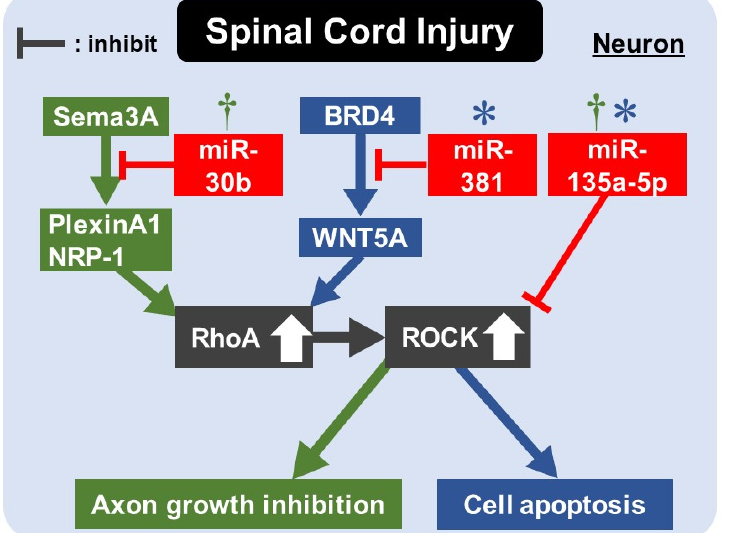
Figure 3. Schematic representation of the interaction between the Rho/ROCK pathway and miRNAs in spinal cord injuries. Spinal cord injuries trigger multiple signaling pathways that upregulate the Rho/ROCK pathways in neurons, leading to neuron cell apoptosis and axon growth inhibition. MiR- NAs inhibit these signaling pathways, resulting in reduced cell apoptosis and the promotion of axon regeneration. † miRNA involving oxidative stress. * miRNA involving cell apoptosis. Sema3A: Sem- family member 5A; ROCK: